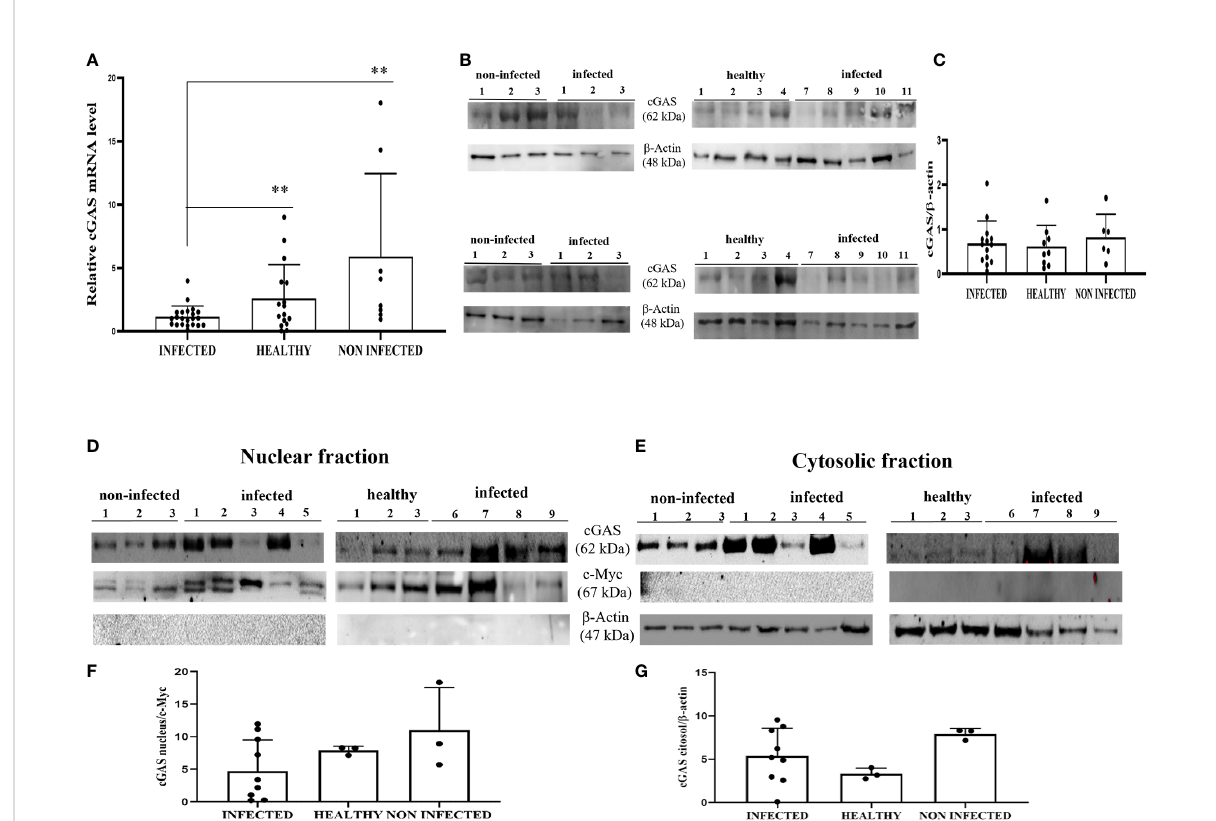
FIGURE 1 (A) RT-qPCR analysis of cGAS mRNA levels in infected, non-infected, and healthy bladder samples, respectively. cGAS mRNA was signi fi cantly reduced in infected bladder samples compared with that in both non-infected and healthy bladder samples (**p ≤ 0.01). (B) Western blot analysis of cGAS in infected, non-infected, and healthy bladder samples. (C) Densitometric analysis was performed by comparing the protein expression levels of total cGAS with b -actin. (D, E) cGAS western blot of nuclear and cytosolic fractions of infected, non-infected, and healthy bladder tissues. (F, G) cMyc and b -actin was used to verify the selectivity of the extracts and perform the densitometric analysis. There was no statistically signi fi cant variation in cGAS protein levels in total and in differentiated fractions in infected bladder tissue compared with both non- infected and healthy bladder samples. Plots present measurements from each sample performed in